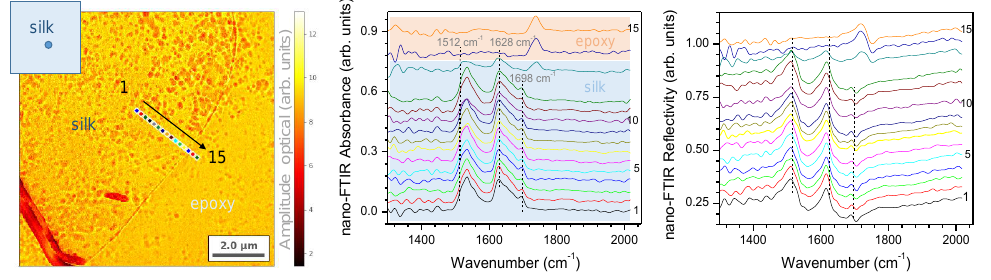
Figure 4. Transverse slice of silk. SNOM map and the amplitude and phase of scattered field at 15 equidistant points across the silk–epoxy